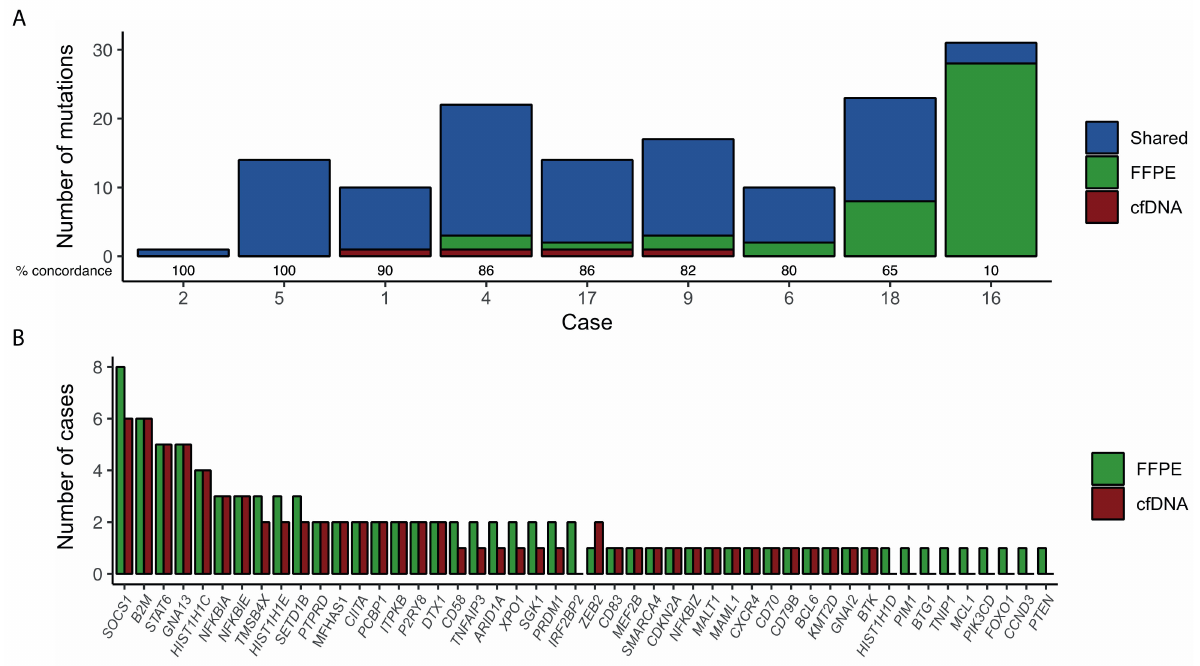
Figure 2. Concordance between mutations detected in cfDNA and matched tumor gDNA. ( A ) Number of mutations by case. Mutations are coded by color according to whether they were detected in both samples (blue), only in the FFPE sample (green), or only in cfDNA (red). The percentage of concordance is showed for each case; ( B ) Prevalence of somatic mutations detected by NGS in cfDNA and